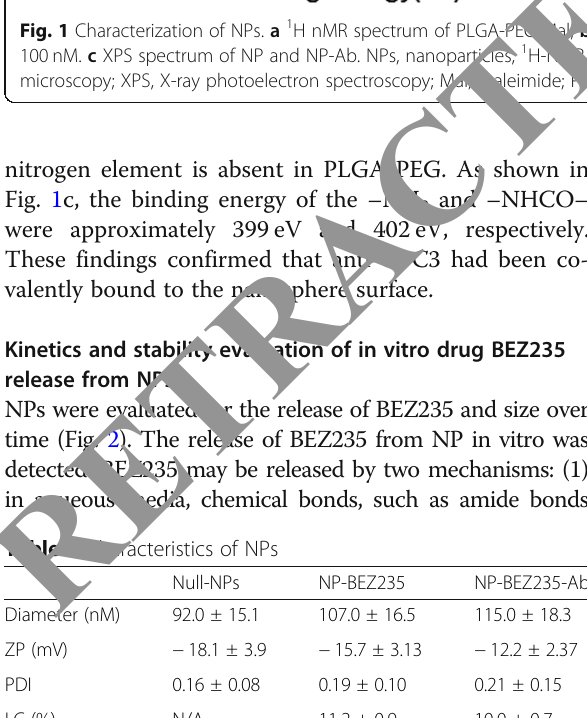
Fig. 1c, the binding energy of the – NH were approximately 399 eV and 402 eV, respectively.